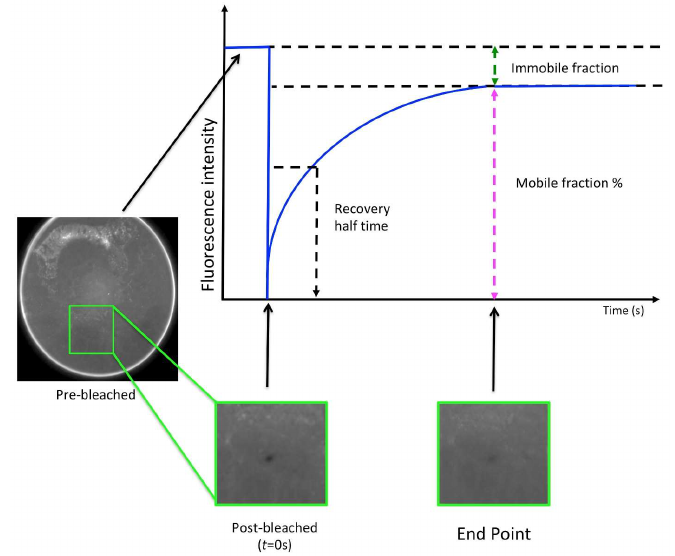
Figure 10. Representation of the fluorescence recovery after photobleaching (FRAP) recovery curve. The di ff usion rate of a protein in LCP can be determined by FRAP, which measures the amount of time required for the fluorescence intensity of a tagged protein to di ff use out from the bleached area. The di ff usion rate is given by the recovery curve and proportional to slope of the curve at the starting point (t = 0 sec)